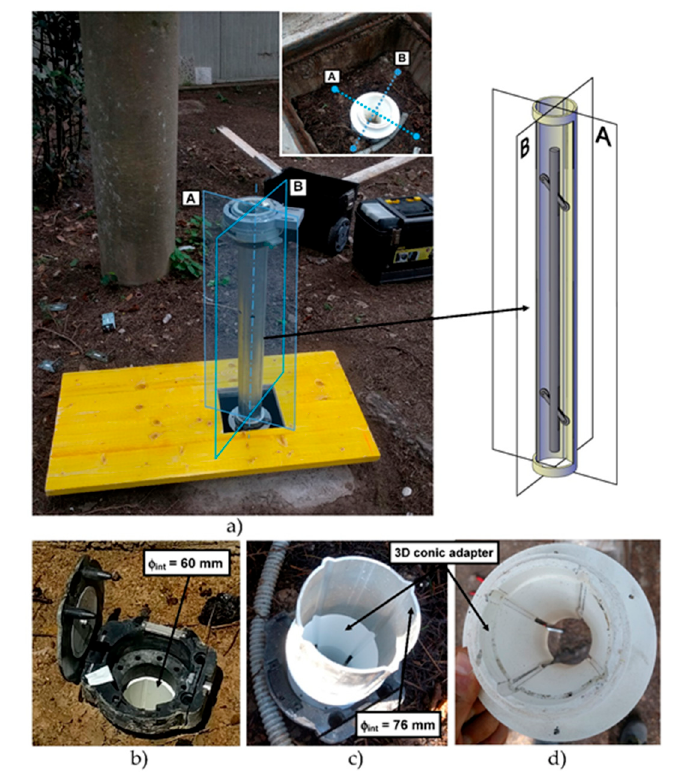
Figure 8. ( a ) Inclinometer probe setup during the AIS installation in each section. The A channel is represented by the plane that contain the wheels and the B channel represents the orthogonal plane; ( b ) the inclinometer casing before AIS installation; and ( c , d ) 3D printed conical adapter for coupling the two pipes of different diameters (ABS—62 mm and aluminum—76 mm).